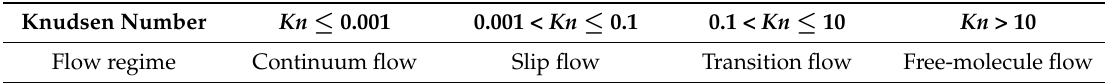
Table 1. Classification of gas flow regimes based on Knudsen number.